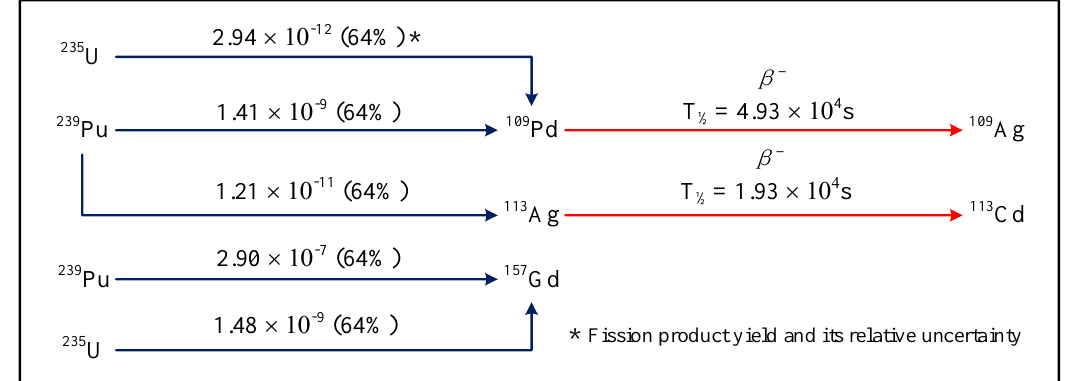
Figure 8. Special fission and decay model. Moreover, the fission product uncertainty of 239 Pu contributes significantly to the nu- clide density relative uncertainties of 113 Cd and 157 Gd. From Figure 8, 239 Pu fission does not produce 113 Cd directly, whereas it is generated by the decay of 113 Ag, whose half-life is alone. A similar phenomenon can be seen in that of 239 Pu and 241 Pu. around 5.4h and is produced by 239 Pu. Considering the relative uncertainty of 113 Ag fission product yield in 239 Pu is large (around 64%), and it could be responsible for the consider- able nuclide density relative uncertainty of 113 Cd. Fission product yield and the fission product yield uncertainty data of 157 Gd ( y i = 2.90 10 −7 , σ i = 1.86 10 −7 ) ( σ i : standard deviation of each fission product yield) generated by 239 Pu fission are larger than that of 235 U ( y i = 1.48 10 −9 , σ i = 9.47 10 −1 0 ). Therefore, perturb- ing 239 Pu fission product yield leads to a larger nuclide density relative uncertainty of 157 Gd.